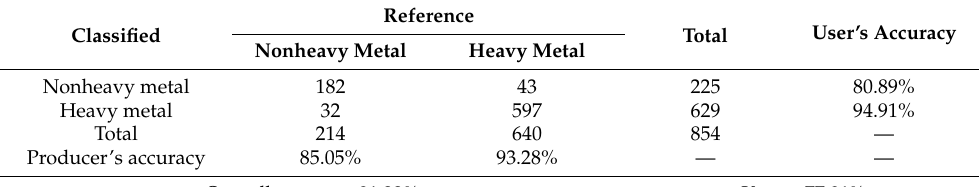
Table 4. Classification accuracy evaluation in